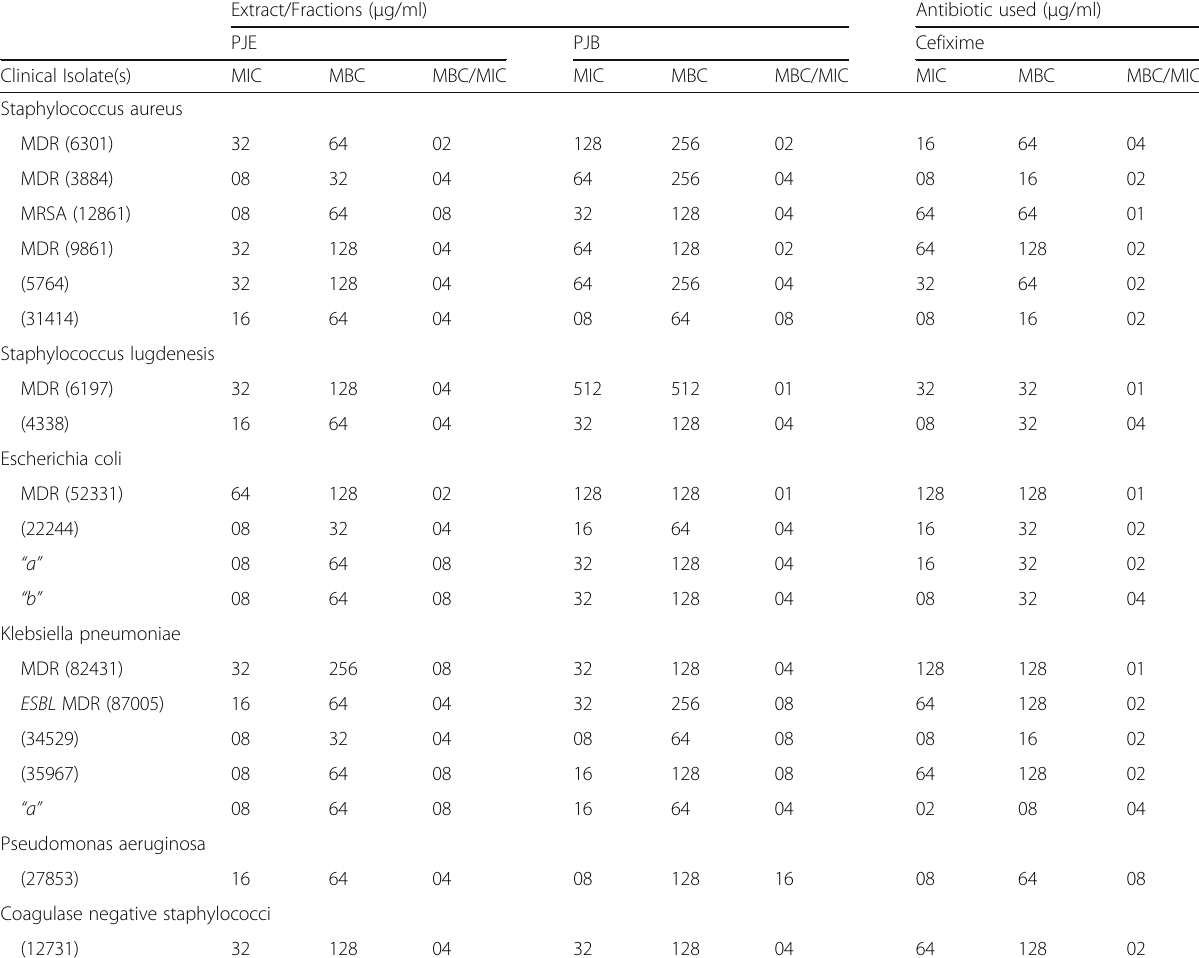
Table 6 MIC and MBC of P. jacquemontiana extracts and cefixime against gram positive and gram negative bacteria Extract/Fractions ( μ g/ml)